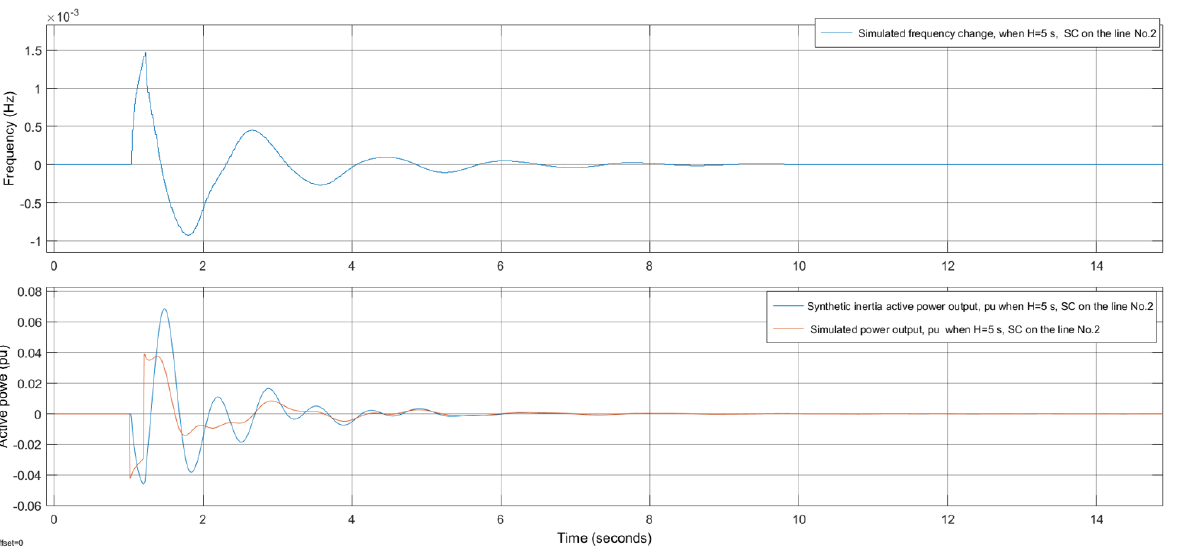
Figure 9. Comparison of active power outputs of SI algorithm and simulated power output when H = 5 s when 3ph short circuit (SC) in the overhead line is close to the generating source with the SI algorithm.